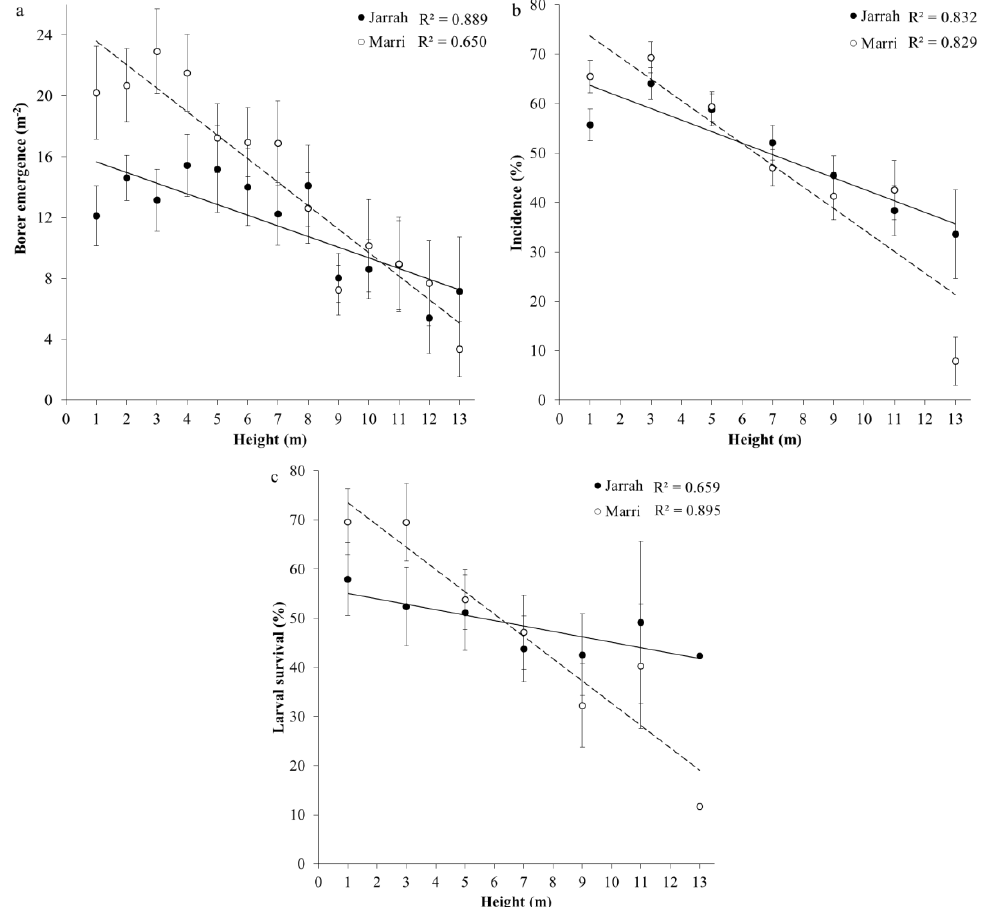
Figure 2. Relationship between mean (± SEM) (a) density of borer emergence (m −2 ), (b) incidence of larval galleries (%) and (c) larval survival (%) (neonates to larvae that had at least reached the pupal stage) of the Australian eucalyptus longhorned borer Phoracantha semipunctata with height (m) of 1 m sections up to 13 m in height for jarrah ( Eucalyptus marginata • ) ( n = 38) and marri ( Corymbia calophylla ○ ) ( n = 39) trees in the Northern Jarrah Forest (NJF), Southwestern Australia. Table 2. Fitted models for borer emergence (m −2 ), incidence of larval galleries (%) and larval survival (%) of the Australian eucalyptus longhorned borer Phoracantha semipunctata as a function of height (m), diameter (cm) and bark thickness (mm) of jarrah ( Eucalyptus marginata ) and marri ( Corymbia calophylla ) trees in the Northern Jarrah Forest (NJF), Southwestern Australia. Associations were analysed by least squares regression. Associations <0.001 Emergence and incidence data were analysed using a GLMM procedure for non-normal data. For the first model, the number of borers that emerged was significantly dependent on species, and negatively correlated with the height of a tree section above ground (m) and positively correlated with section diameter (cm), with significant interactions except for species and diameter (Table 3). A second model, adjusting for bark area (m 2 ) of each 1-m section, showed that the density of borer emergence (m −2 ) was significantly dependent on tree species, and negatively correlated with the height of a tree section, with a significant interaction between height and diameter (Table 3). For the third model, incidence was not dependent on species and negatively correlated with height and positively correlated with section diameter (cm), with a significant negative interaction with height and diameter (Table 3).